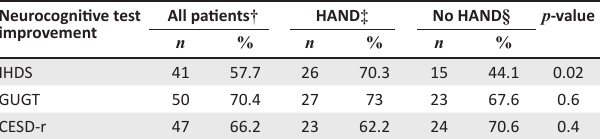
TABLE 3: Neurocognitive scores after 6 months antiretroviral therapy